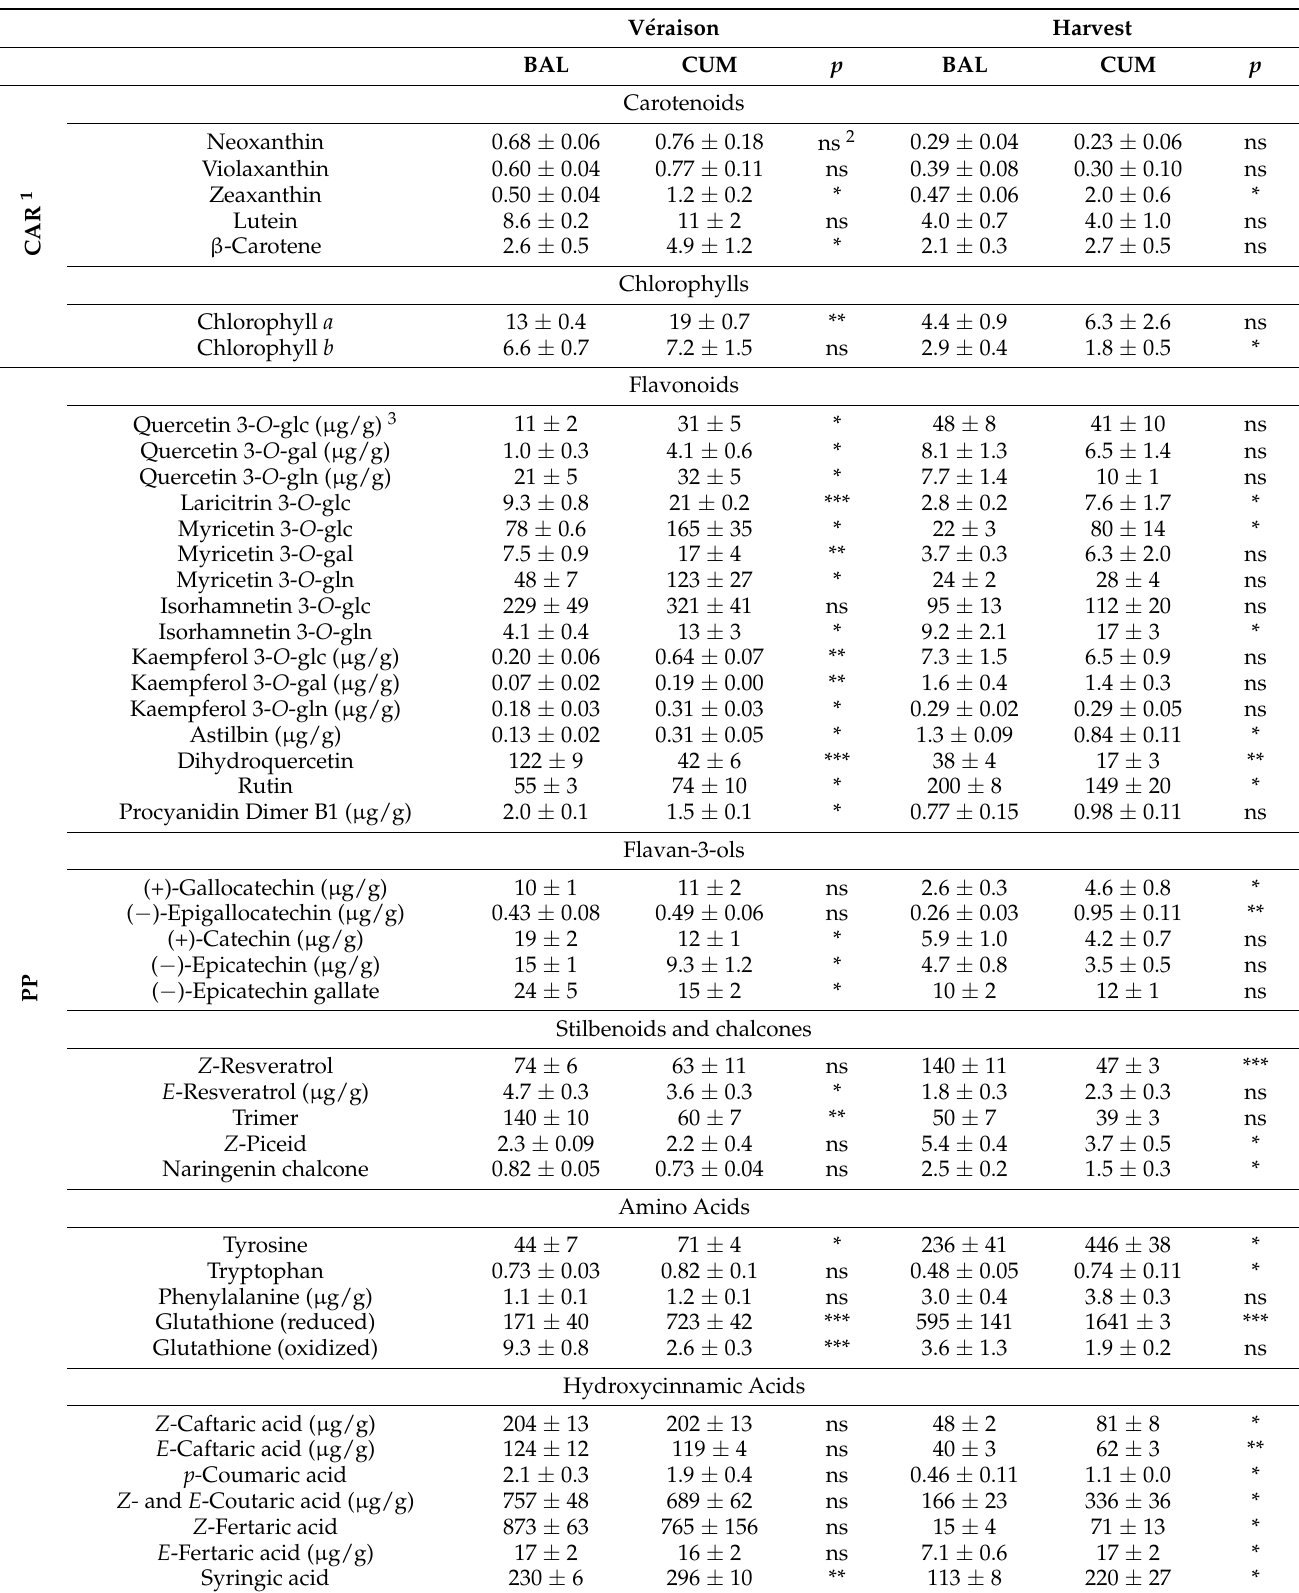
Table 1. Composition (CAR, PP and FV) of nondefoliated samples from BAL and CUM at v é raison and harvest. V é raison Harvest BAL CUM